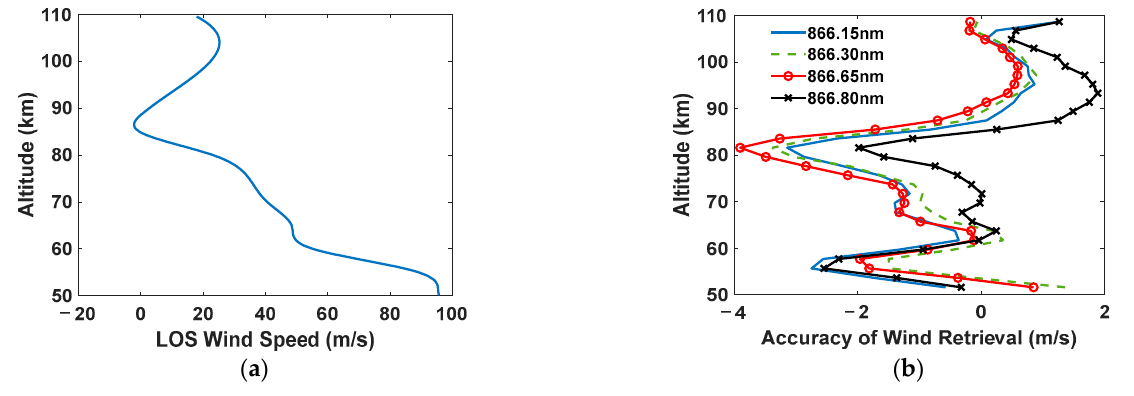
Figure 13. The input wind speed of the simulation and the wind retrieval accuracy of the four lines. ( a ) The input LOS wind speed involved in the simulation. ( b ) The wind retrieval accuracy profile of the four emission lines.